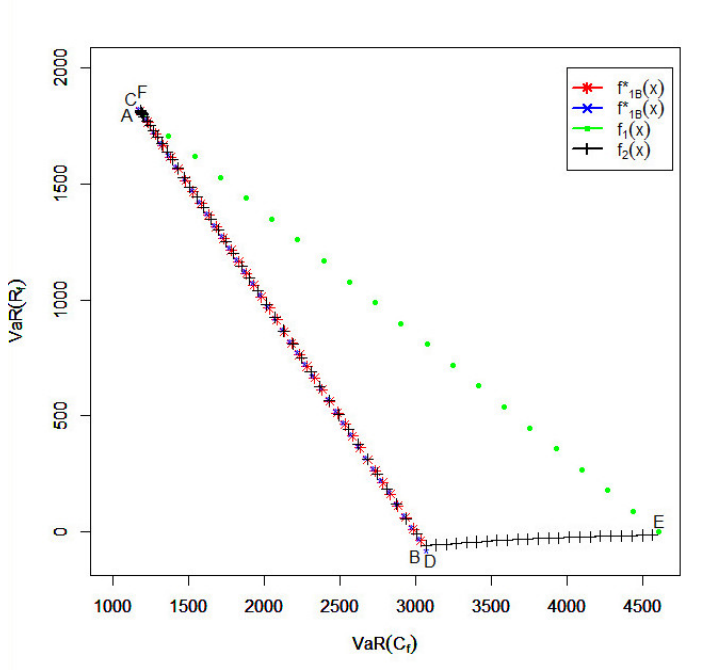
Figure 6. VaRs of the cedent and the reinsurer under different policies: Scenario